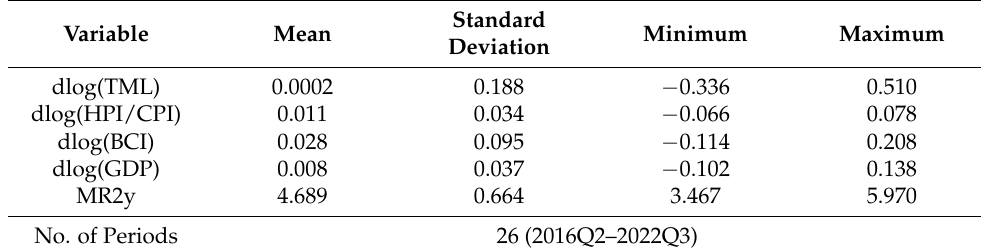
Table 1. Descriptive statistics of variables,